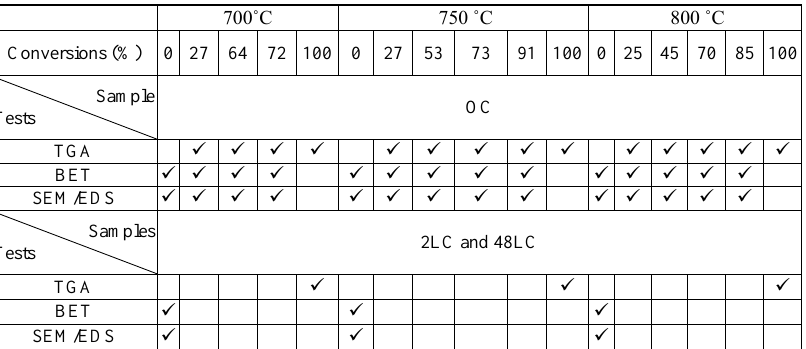
Table 2. Summary of experiments and